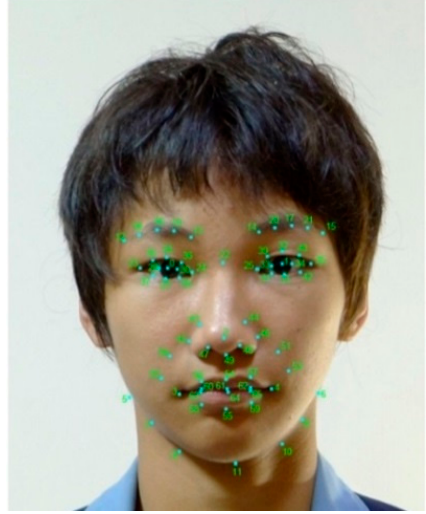
Figure 1. Luxand FaceSDK detects 66 facial characteristic point.